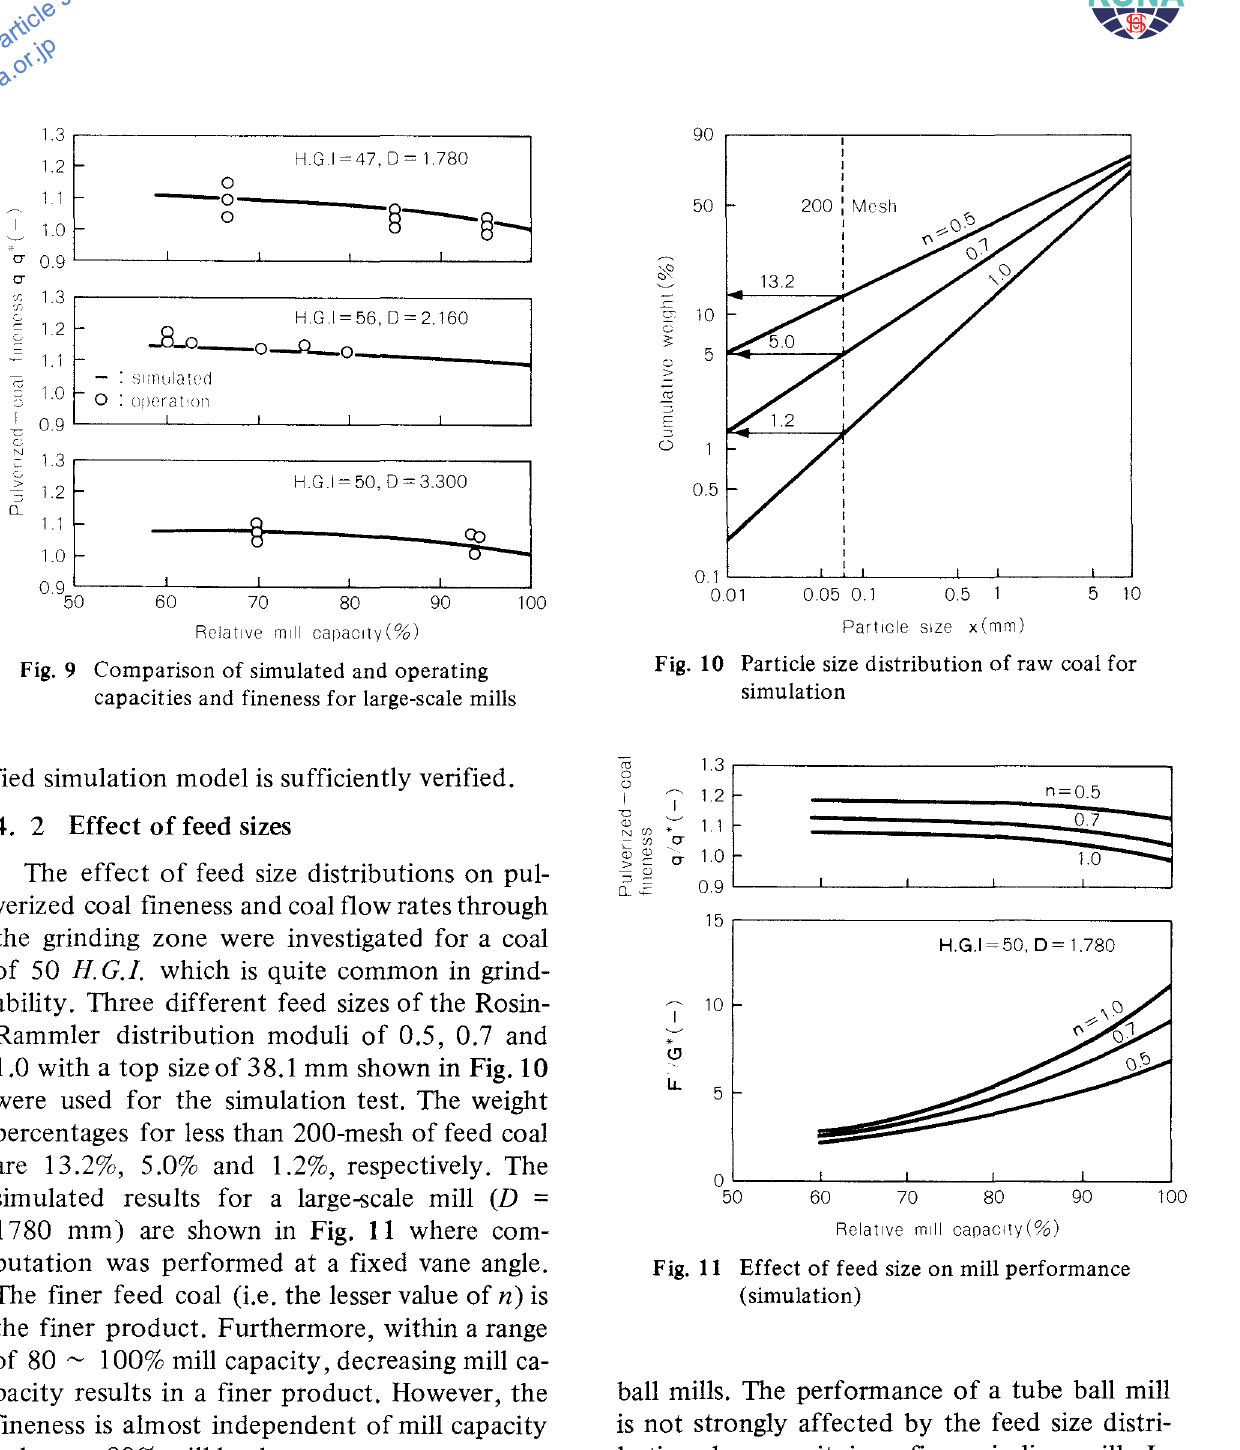
ball mills. The performance of a tube ball